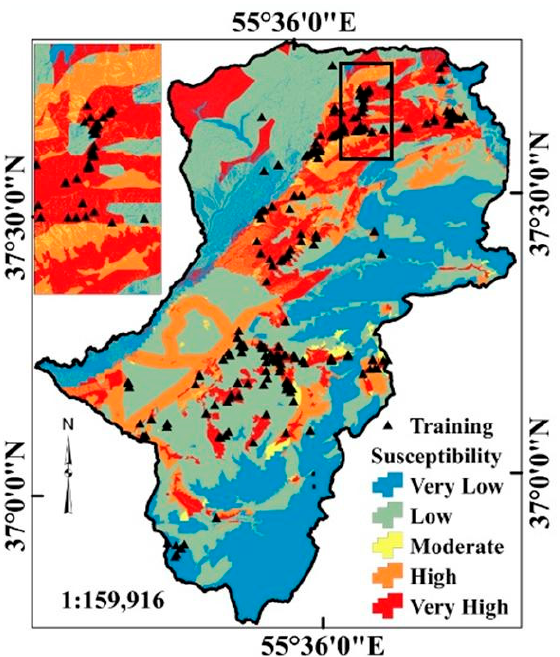
Figure 7. Landslide susceptibility map based on the ADTree model.